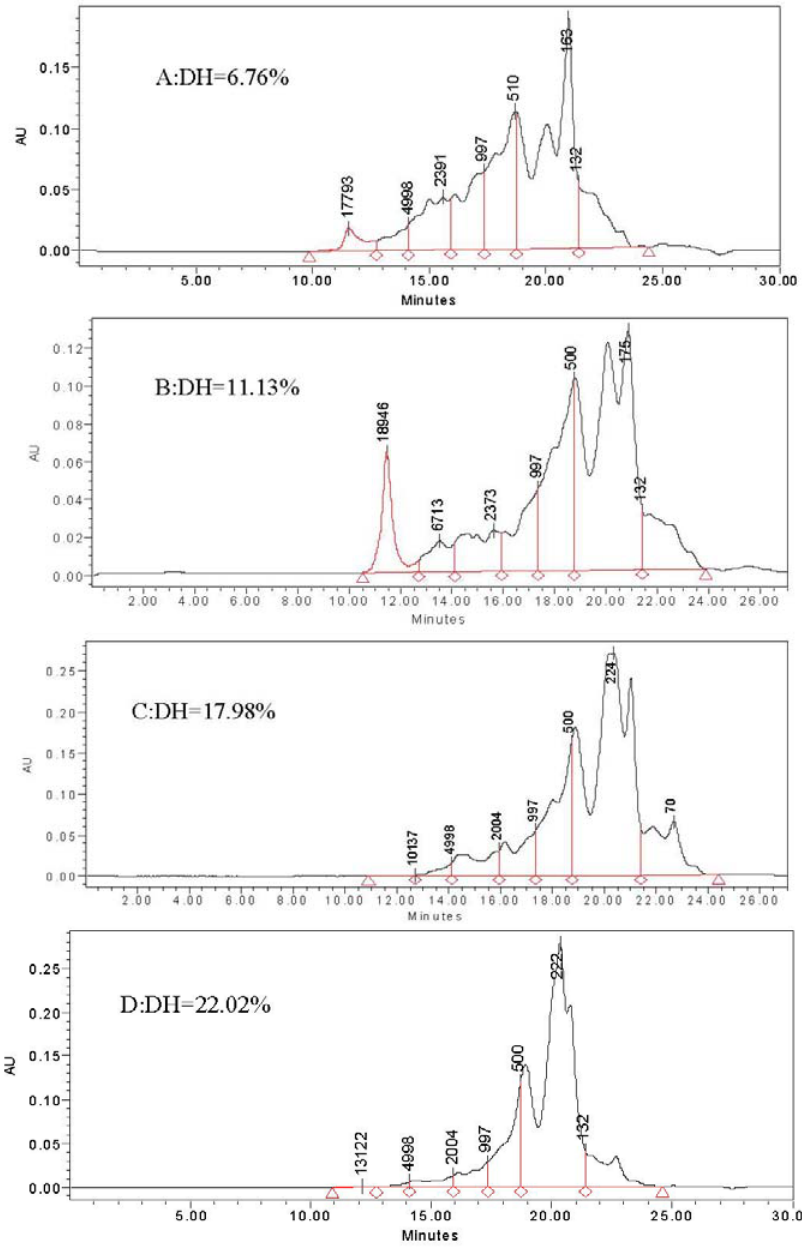
Figure 3. Effect of DH on the molecular weight distribution of